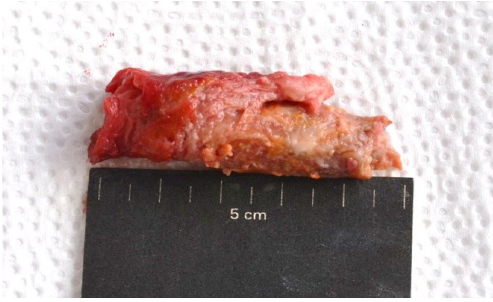
Figure 7. Thrombus of approximately 5cm long found in the main pulmonary artery of the dog which died due to heartworm infection.